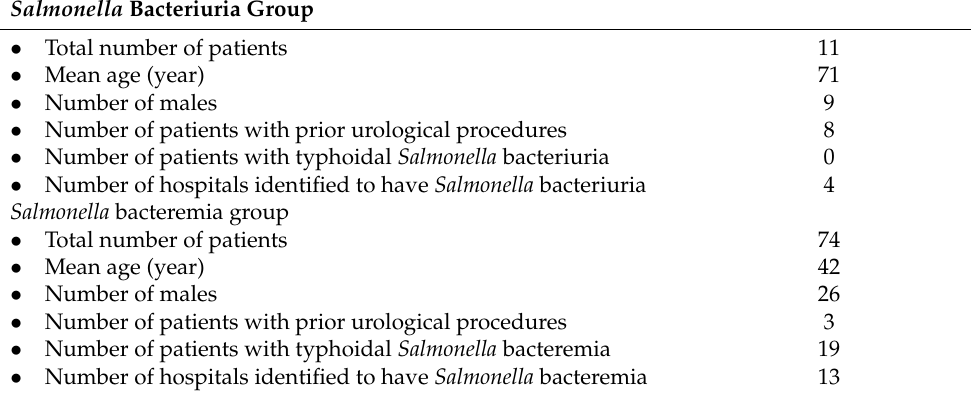
Table 1. Demographics of patients identified to have Salmonella bacteriuria and bacteremia in